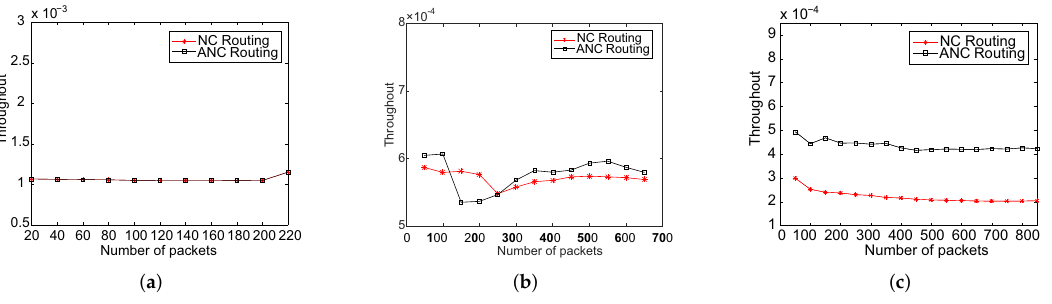
Figure 6. Comparison of throughput between NCR and ANCR. ( a ) 2 data streams; ( b ) 5 data streams; ( c ) 20 data streams.